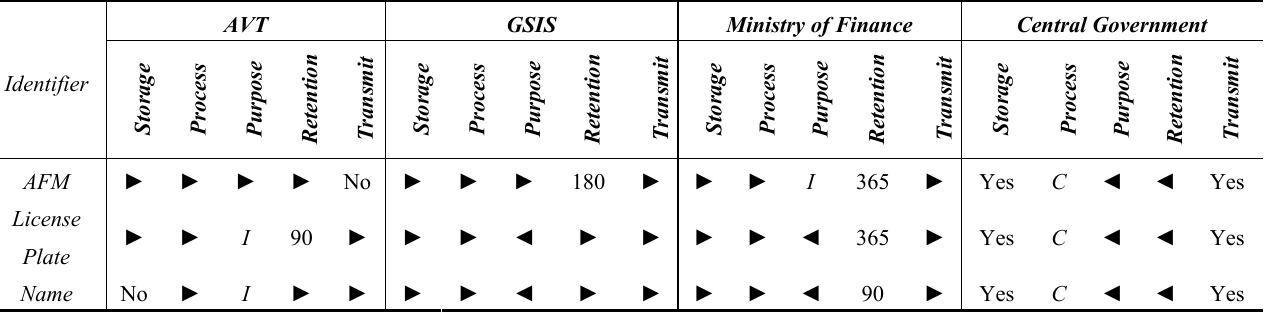
Table 5. Composition of AVT Service Privacy Policy